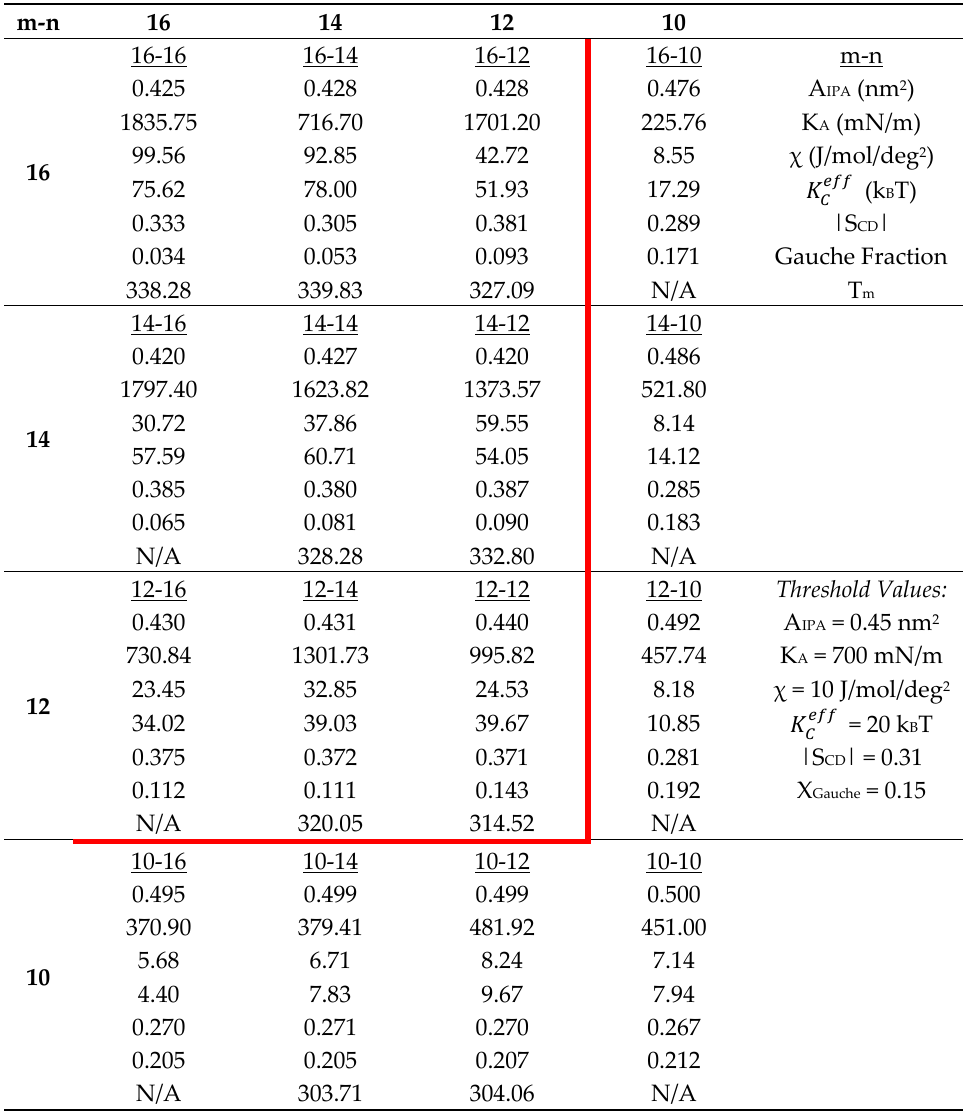
Table 2. Structural and mechanical characteristics for all the tested C m TMA + -C n S − IPA systems. The m-n combination, area per IPA complex A IPA (nm 2 ), area expansion modulus K A (mN/m), molecular tilt modulus χ (J/mol/deg 2 ), effective bending rigidity K ef f (k B T), average |S CD | and gauche factions for IPA middle alkyl segments, and experimental transition temperature (T m ) are noted sequentially for each system [12]. Red line shows the phase-boundary dividing the S and the Ld phases: IPA systems with both m ≥ 12 and n ≥ 12 are in the gel phase, and otherwise (m or n ≤ 10) in the Ld phase. The threshold values of membrane properties corresponding to the phase boundary are also listed.